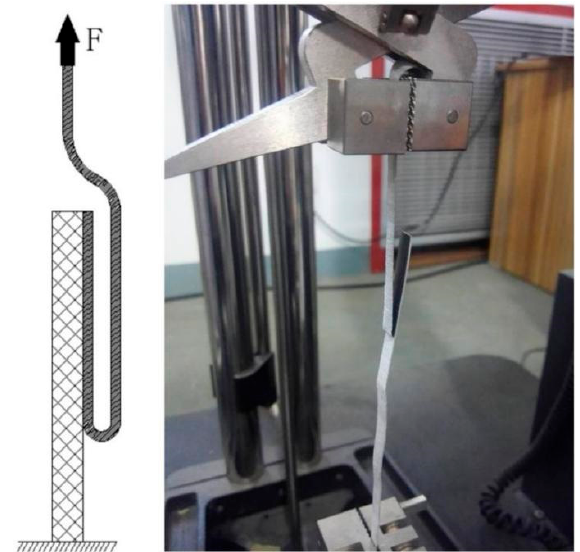
Figure 2. Peel test for Ti/Al composite